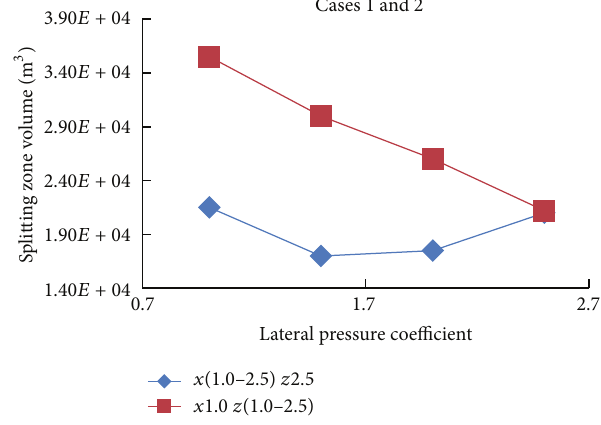
Figure 21: Splitting zone volume versus lateral pressure coefficient in cases 1 and 2 .